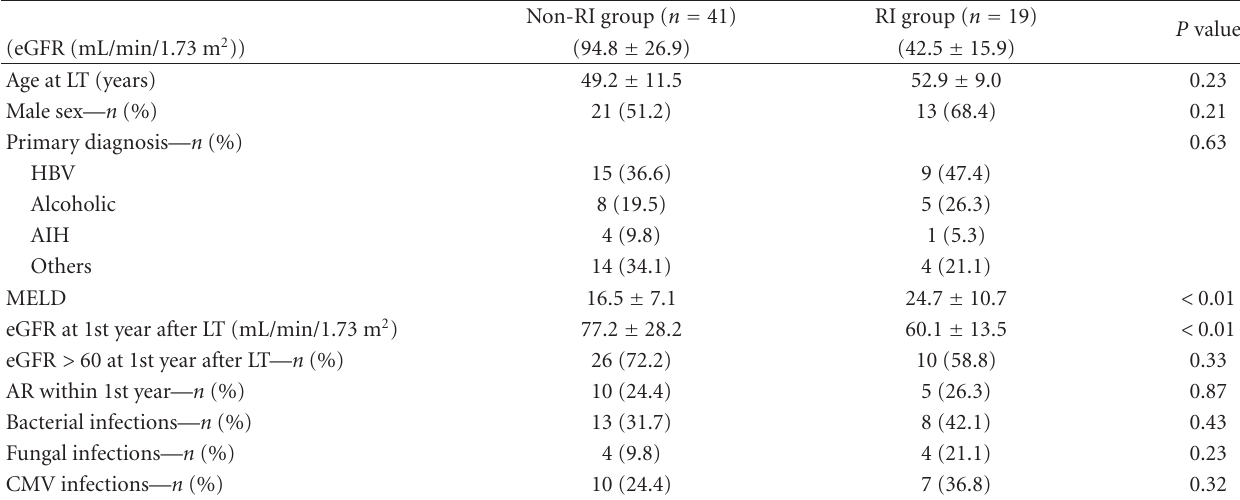
Table 1: Patient characteristics at living donor liver